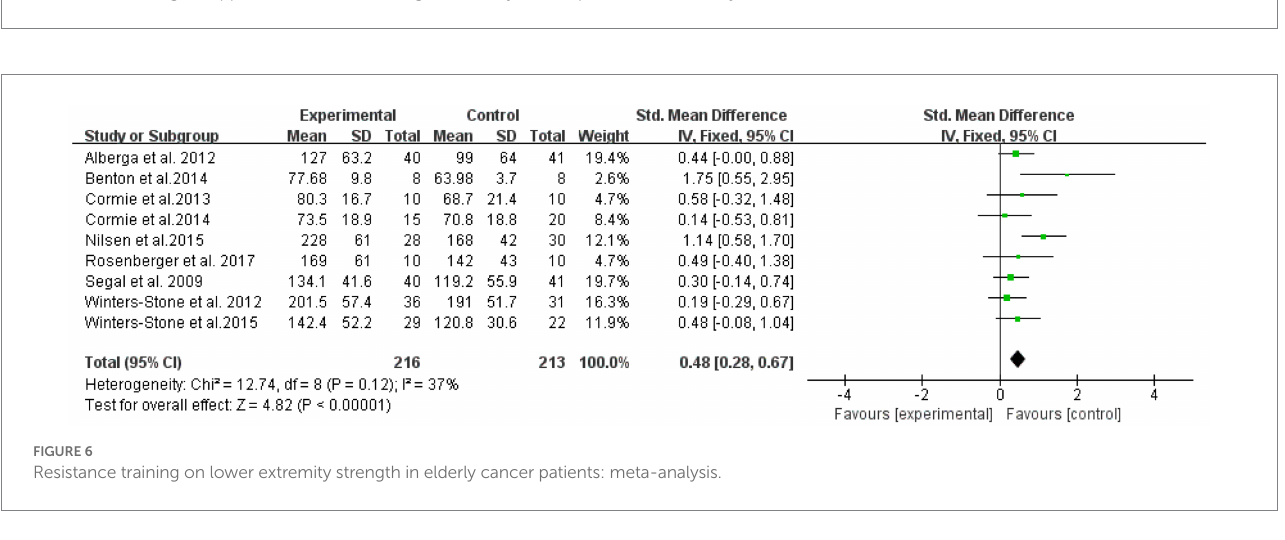
FIGURE 5 Resistance training on upper limb muscular strength in elderly cancer patients: meta-analysis.